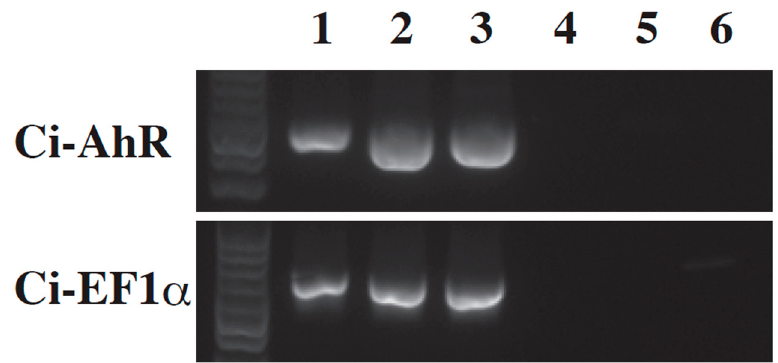
Figure 3. RT-PCR analysis of Ci-AhR and Ci-EF1 α . Ci-AhR mRNA expression was determined in the swimming larva (lane 1), mid body axis rotation (lane 2), and early juveniles (lane 3) stages. No amplification was detected in the no reverse transcription template (lane 4–6). Ci-EF1 α was amplified as an internal control.